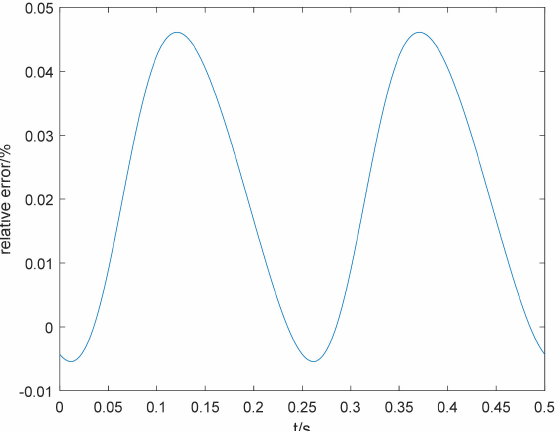
Figure 8. Relative error of the time-varying stiffness k ∗